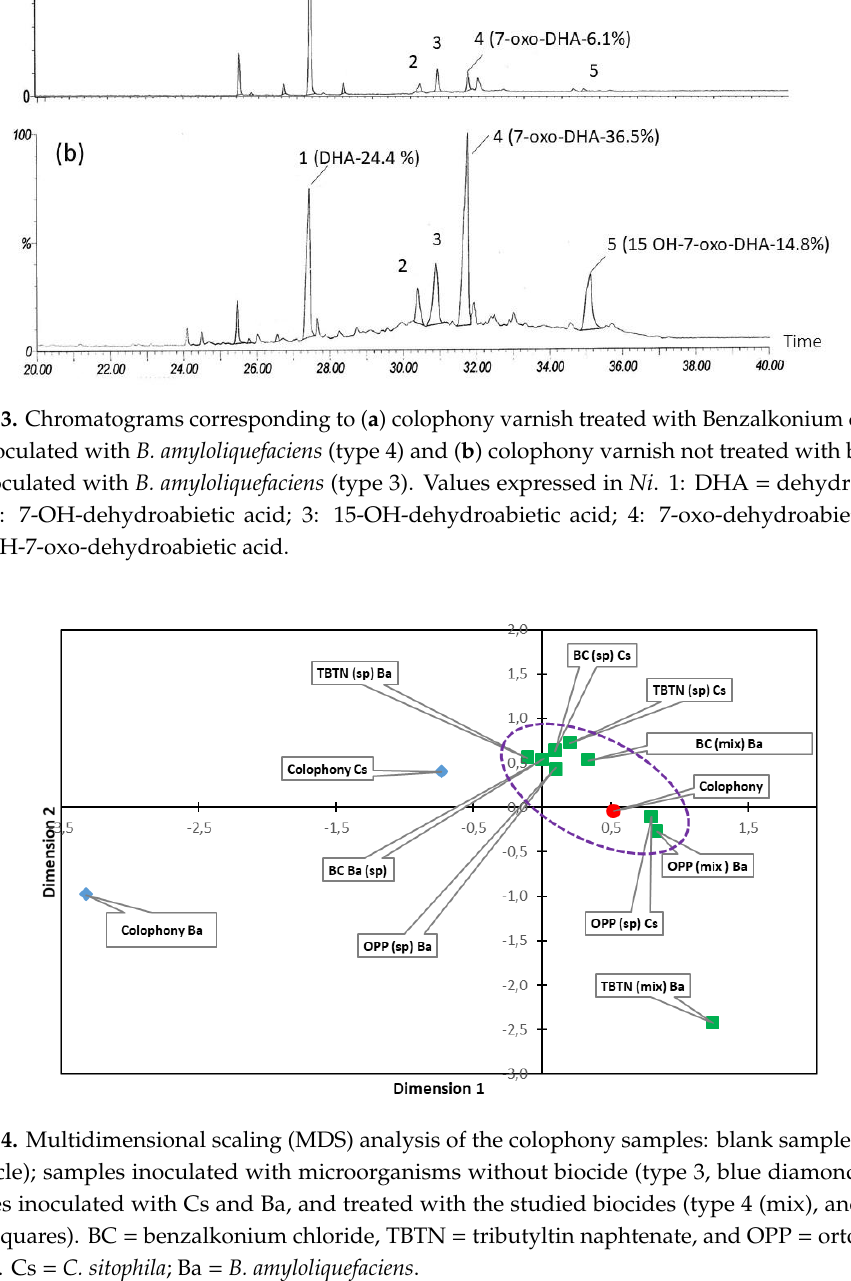
Figure 4. Multidimensional scaling (MDS) analysis of the colophony samples: blank sample (type 1, red circle); samples inoculated with microorganisms without biocide (type 3, blue diamonds); and samples inoculated with Cs and Ba, and treated with the studied biocides (type 4 (mix), and 5 (sp), green squares). BC = benzalkonium chloride, TBTN = tributyltin naphtenate, and OPP = ortophenyl phenol. Cs = C. sitophila ; Ba = B. amyloliquefaciens .